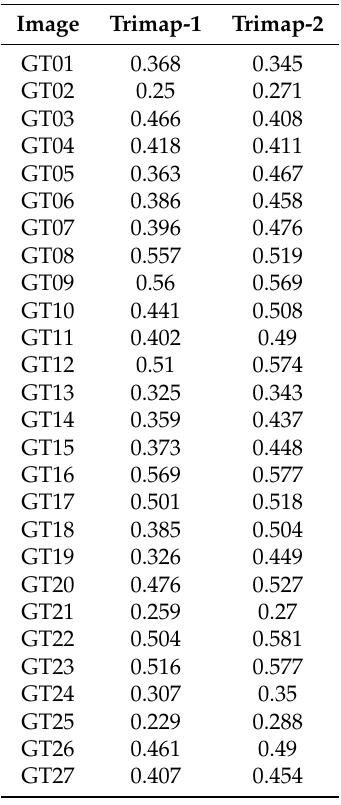
Table 3. Intersection over union (IOU) statistics of the unknown region between the generated trimap and the user input trimap. trimap-1 and trimap-2 represent the trimaps painted with different size